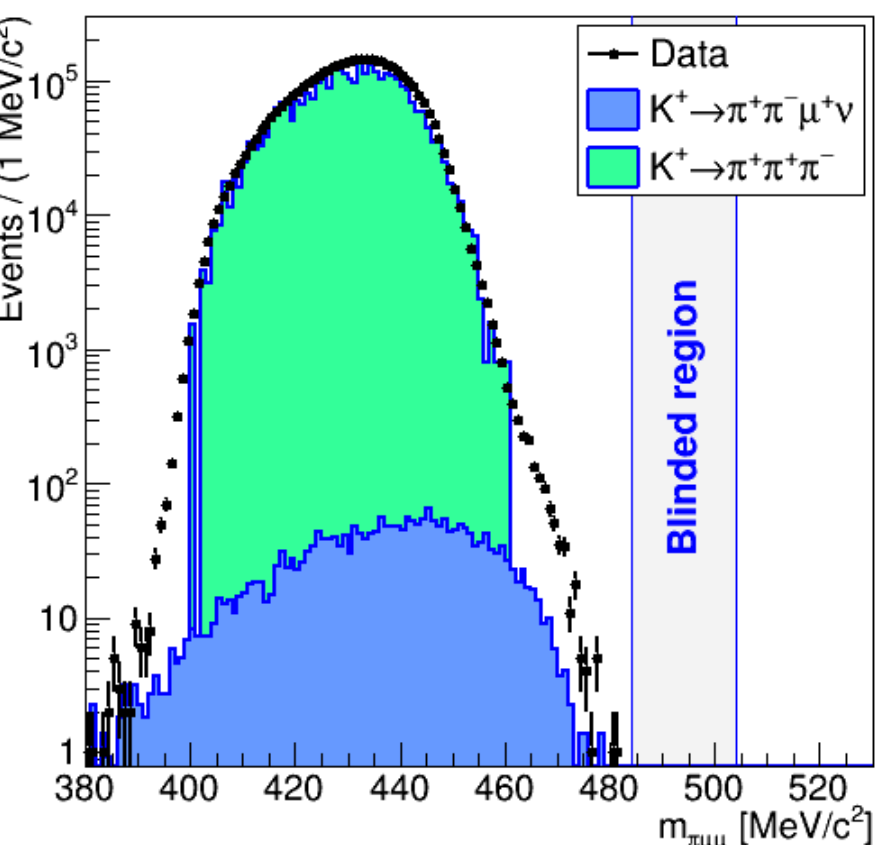
Figure 10. Reconstructed mass spectrum of K + → π + µ + µ − candidates: data and MC estimates of potential backgrounds are visible. The description of the tails of the K + → π + π + π − contribution is limited by simulated statistics; however, data and MC agree within statistical uncertainties